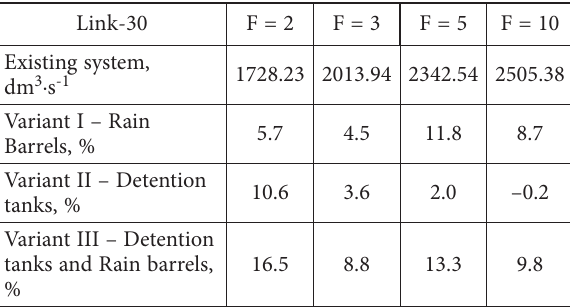
Table 3. Reduction of flow in section